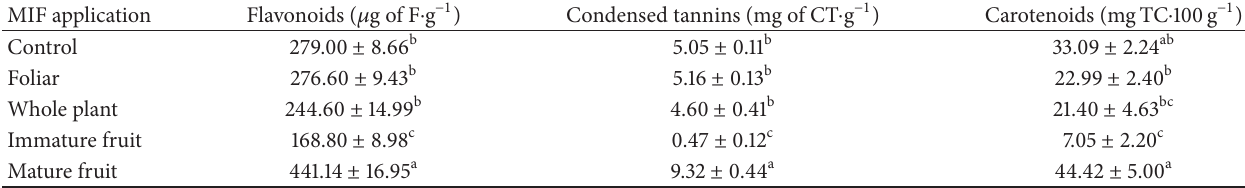
Table 1: Flavonoids, condensed tannins, and carotenoids composition of sweet bell pepper as a result of MIF application ∗